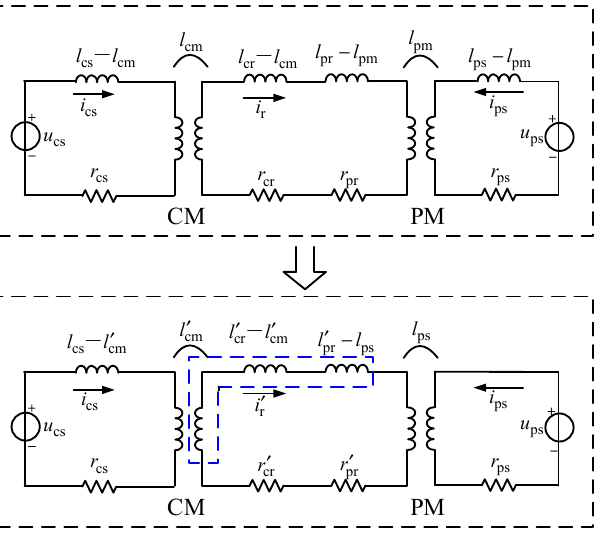
Figure 3. Single-phase equivalent circuit and parameter conversion of BDFM at stationary.